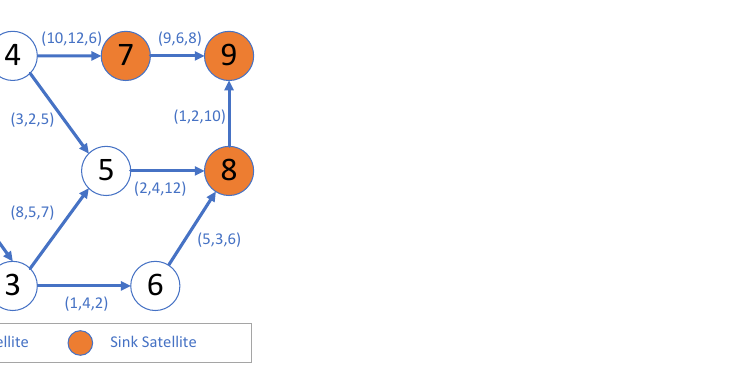
Figure 5. The initial state of spatial information network resource allocation schematic diagram.